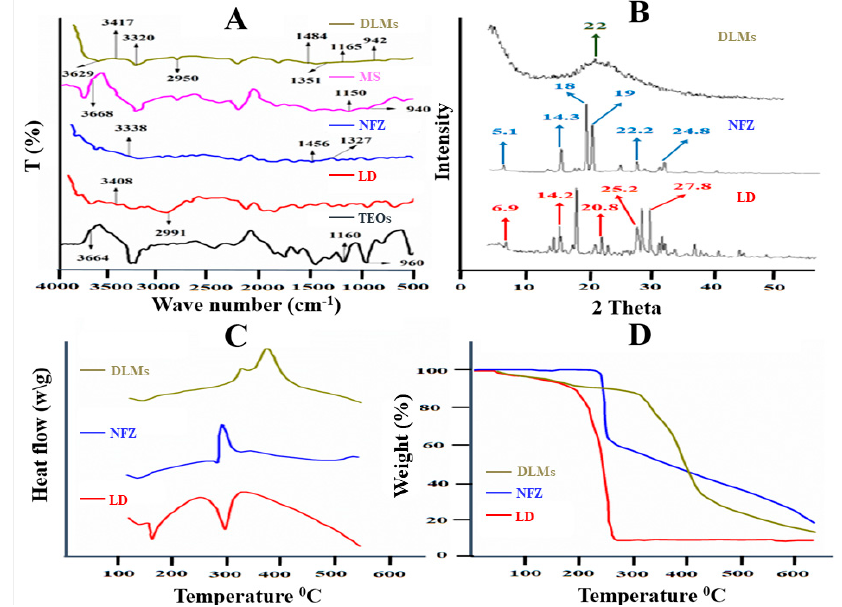
Figure 4. FTIR patterns ( A ); XRD spectra ( B ); thermograms (DSC & TGA) of drug-loaded-optimized silica microspheres and their formulation components ( C , D ).